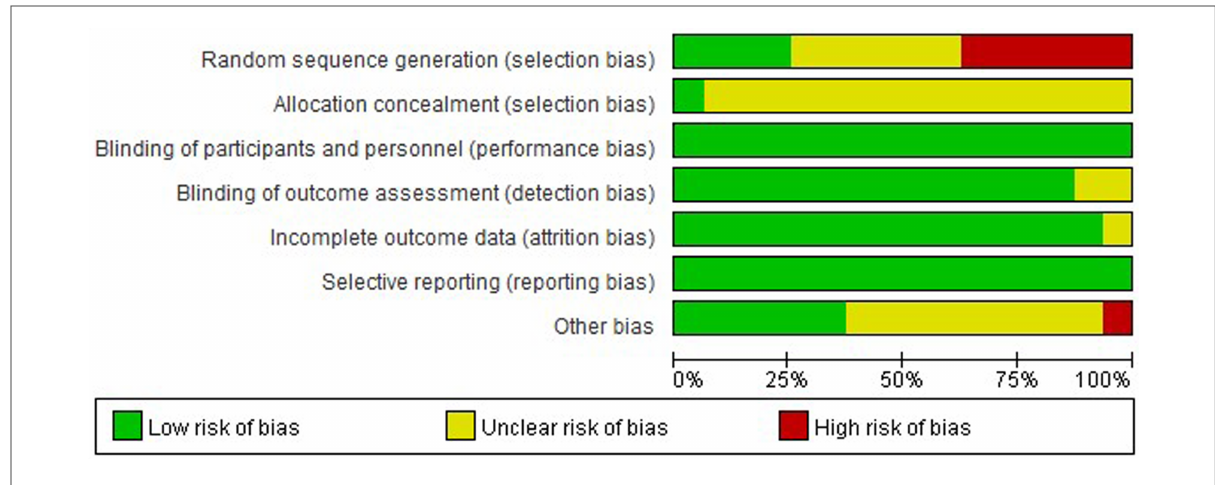
FIGURE 1 Risk of bias summary for all included